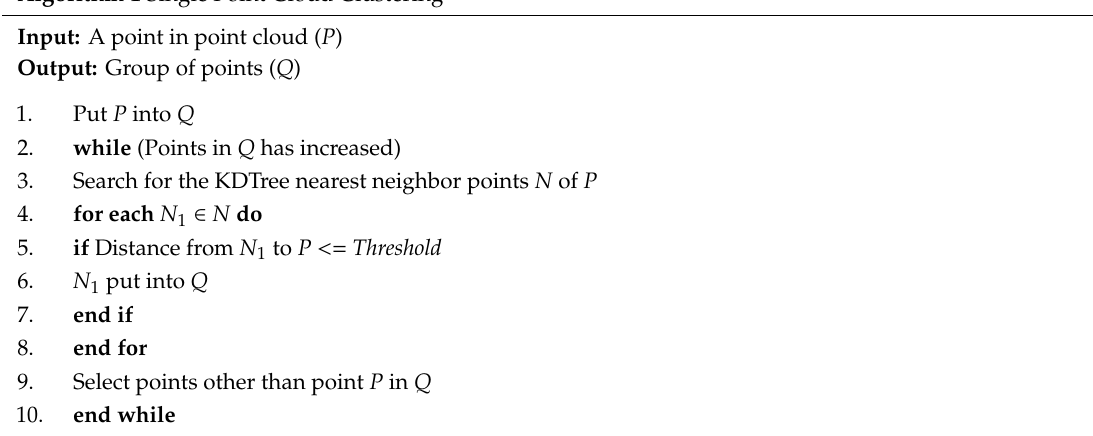
Algorithm 1 Single Point Cloud Clustering